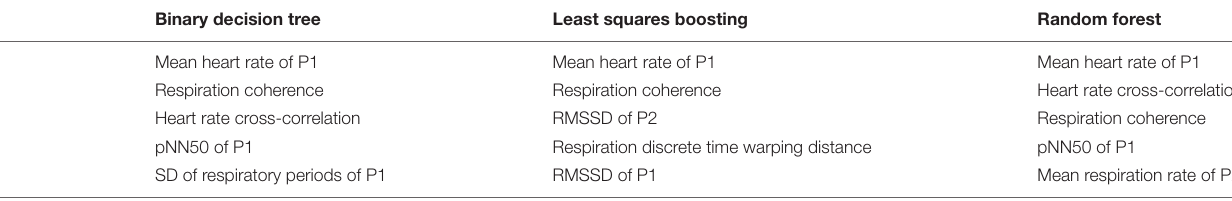
TABLE 3 | The top five most important features for dyad-non-specific engagement estimation using each of the three machine learning methods. Binary decision tree Least squares boosting Random forest